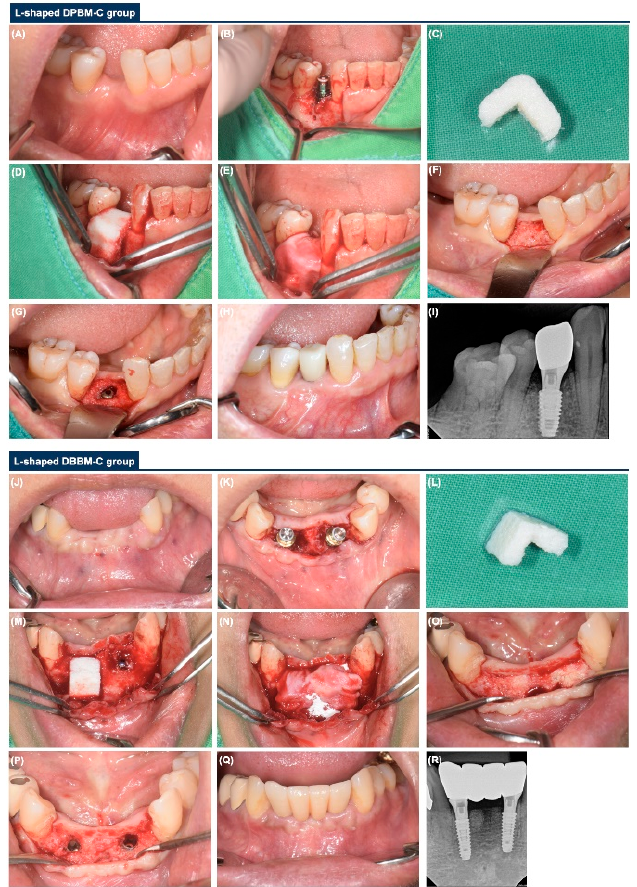
Figure 2. Representative clinical and radiographic images of the L-shaped DPBM-C and DBBM-C groups. ( A ) Facial view before implant surgery. ( B ) Peri-implant dehiscence defect before GBR. ( C ) DPBM-C trimmed to an L-shape. ( D , E ) GBR with an L-shaped DPBM-C and NBCM. ( F , G ) Facial view during re-entry surgery. ( H , I ) Clinical and radiographic view at final prosthesis delivery. ( J ) Facial view before implant surgery. ( K ) Occlusal view during implant surgery. ( L ) DBBM-C trimmed to an L-shape. ( M , N ) GBR with an L-shaped DBBM-C and NBCM. ( O , P ) Facial view during the re-entry surgery. ( Q , R ) Clinical and radiographic view at final prosthesis